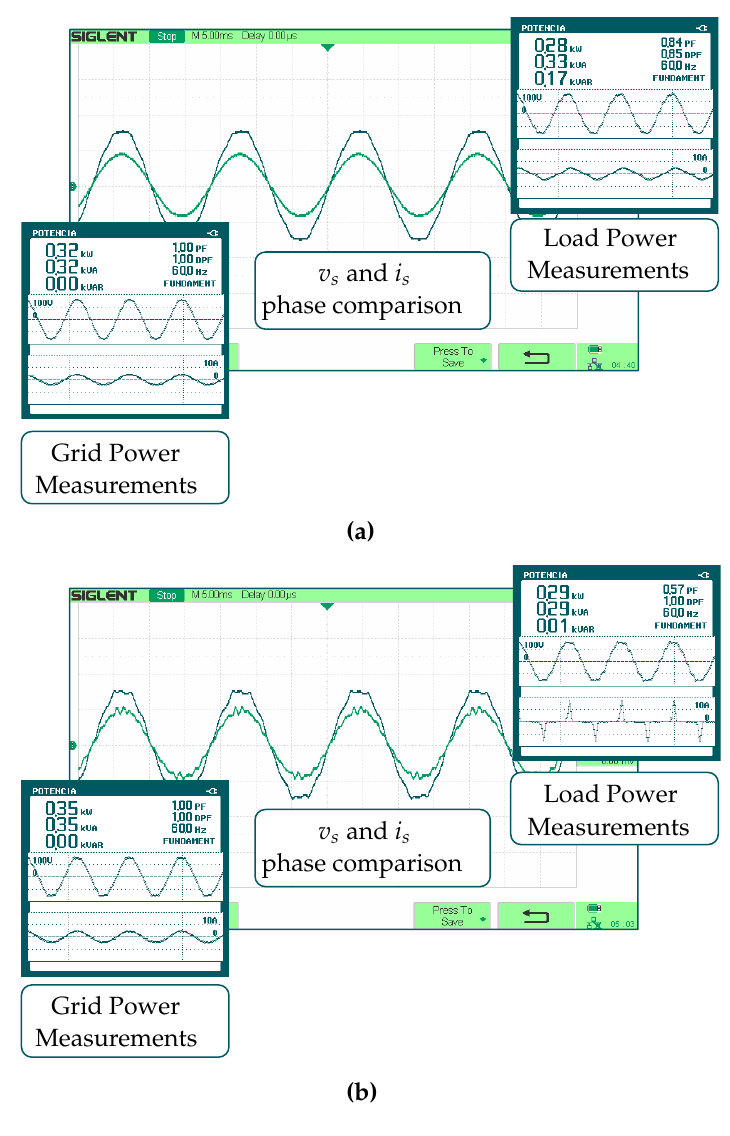
Figure 9. Experimental results for power factor correction in ( a ) RL_30 and ( b )